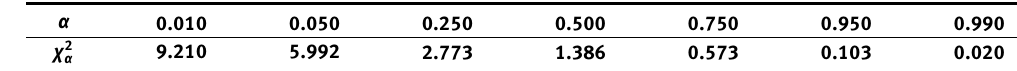
Table 1. Critical values in JB